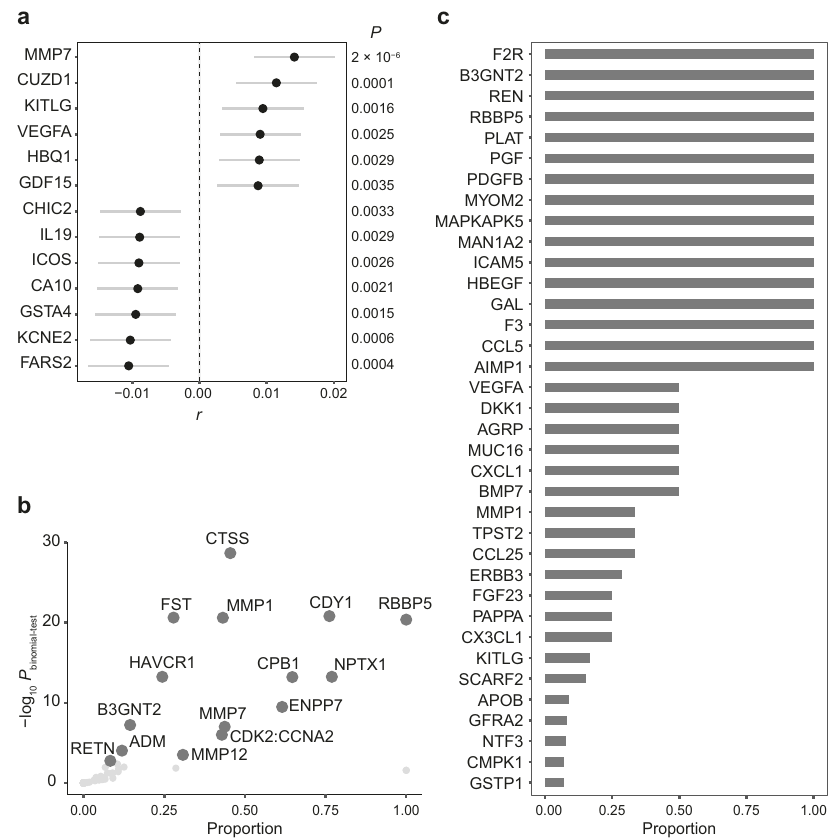
Fig. 2 Extent of pleiotropy between migraine and blood proteins. a Pleiotropy at genome-wide. Pearson correlation (two-sided) between Z scores ( r ) of 113,251 LD-independent SNPs from migraine GWAS and from blood protein GWASs produce signi fi cant results for 13 proteins after adjusting for multiple testing (FDR ≤ 0.05). All correlation results are provided in Supplementary Data 2. Circles represent the correlations ( r ) and the error bars indicate the 95% con fi dence interval. Unadjusted P -values for the correlations are shown on the right. b Pleiotropy at 18,236 protein-coding genes identi fi ed by using MAGMA results and the Exact Binomial test (one-sided). Pleiotropic genes signi fi cantly in fl uence migraine and blood levels of 15 proteins after adjusting for multiple testing (FDR ≤ 0.05). The proportion for each protein is the number of genes associated with both migraine and the protein divided by the number of genes associated with the protein. c Pleiotropy at SNPs within 1703 LD-independent loci identi fi ed by GWAS-PW. Pleiotropic SNPs in fl uence migraine and blood levels of 36 proteins (posterior probability ≥ 0.9). The proportion of the LD-independent loci that in fl uence the blood level of the protein also in fl uence migraine via a shared SNP ranged between 1 and 0.07 (see Methods section for details). Full GWAS-PW results are available in Supplementary Data 5 and 6. For consistency, proteins are reported by encoding gene symbols throughout the